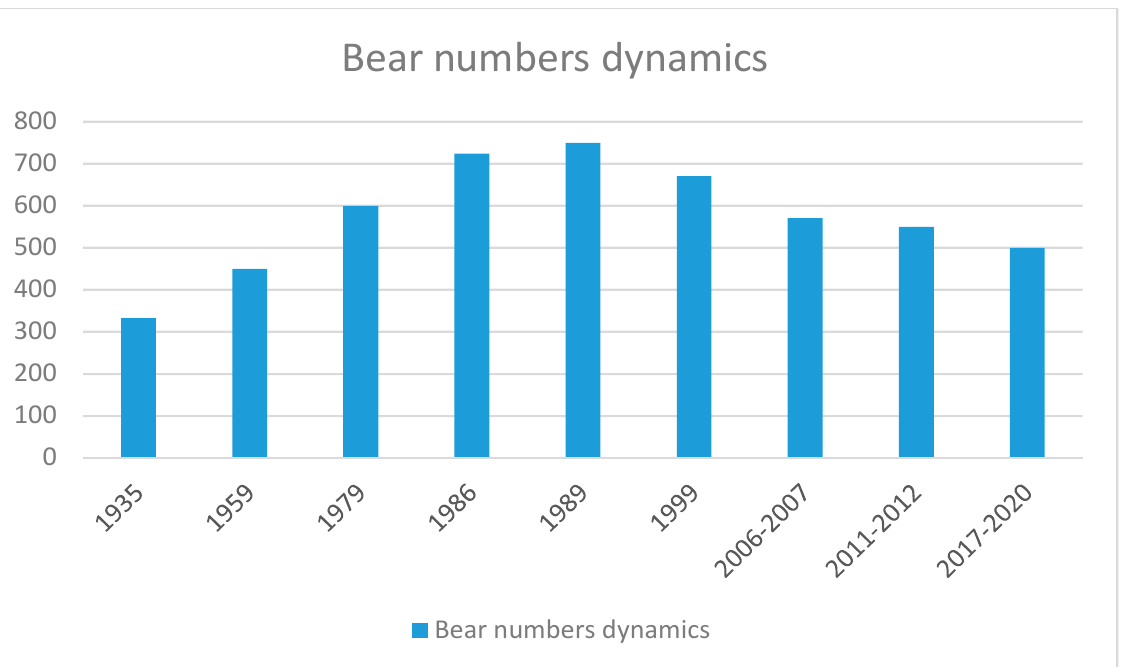
Figure 3. Dynamics of the brown bear population numbers in Bulgaria from the 1930s to 2020. (Data from the sources mentioned in Table 1. The official data from the Ministry of the Forestry and the Ministry of Agriculture were not used: see the text).